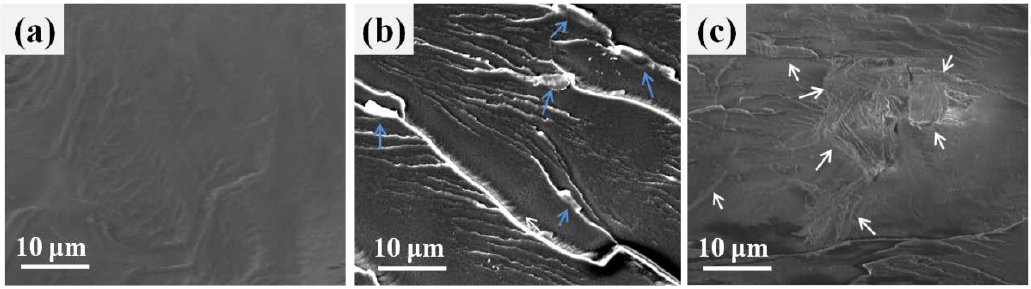
Figure 5. SEM images of PET ( a ), PET/GO ( b ) and PET/GL- g -LMPET ( c ) fractured surface.